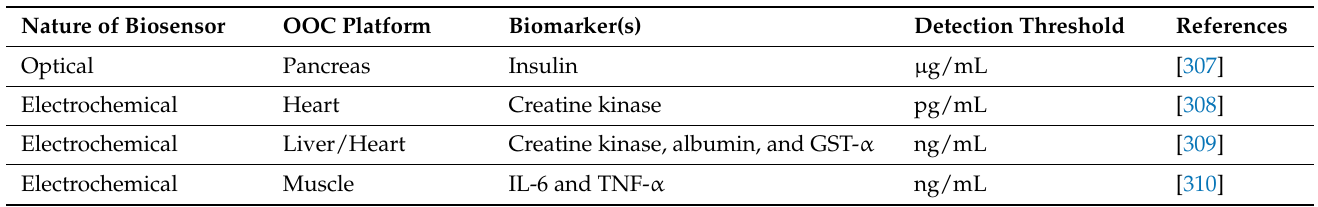
Table 6. Examples of biosensing systems in the monitoring of relevant biomarkers in OOC models. Nature of Biosensor OOC